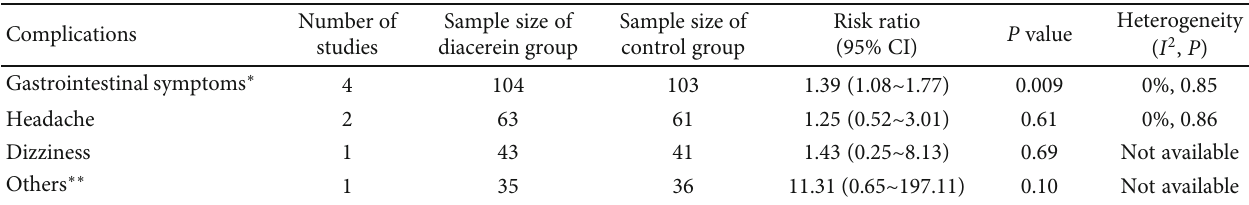
Table 3: Di ff erence of complications between the diacerein group and control